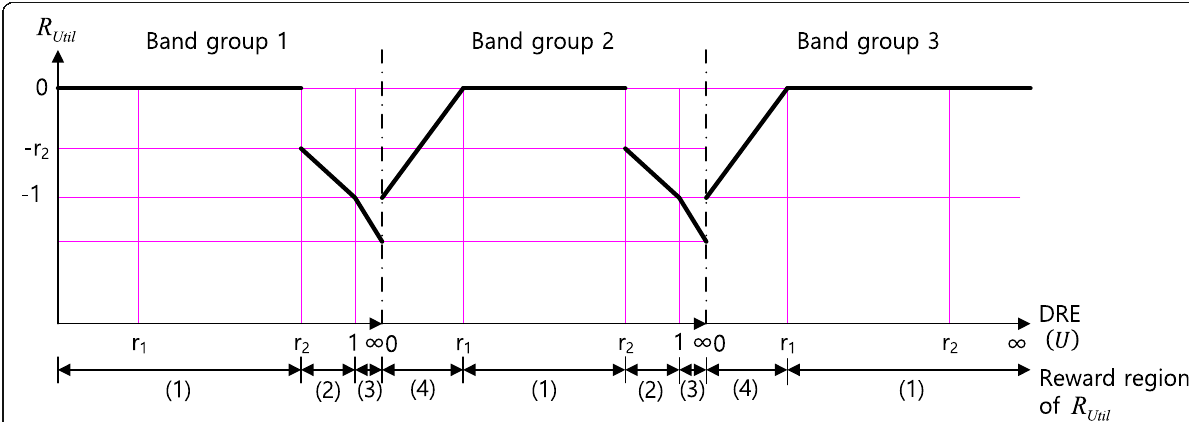
Fig. 8 Utilization efficiency reward according to DRE. To realize the mechanism in Fig. 7, the reward for channel utilization efficiency ( R Util ) is designed as shown. The x -axis for each band group represents the DRE, and the y -axis represents R Util . For the band usage maintenance range, R Util is set to 0. For the band usage change range where the DRE is low, R Util increases from − 1 to 0 since the DRE represents better value as DRE increases. The band usage change range where the DRE is high is divided into [ r 2 , 1) and [1, ∞ ) to distinguish the insufficient transmission rate provided by the channel. R Util represents a more rapid decrease rate in [1, ∞ ). R Util decreases from − r 2 to − 1 in [ r 2 , 1) range and from − 1 to ∞ in [1, ∞ )